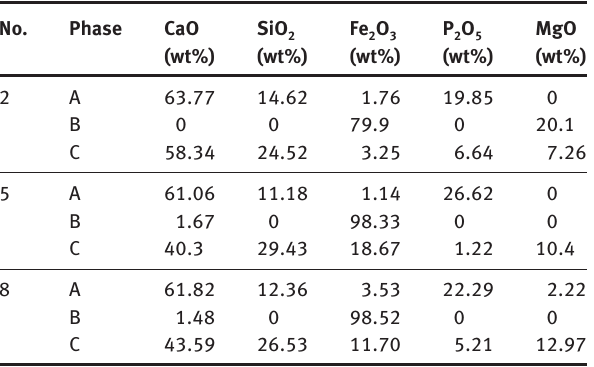
Table 3: The results of the energy spectrum analysis for sample No. 2, No. 5 and No. 8